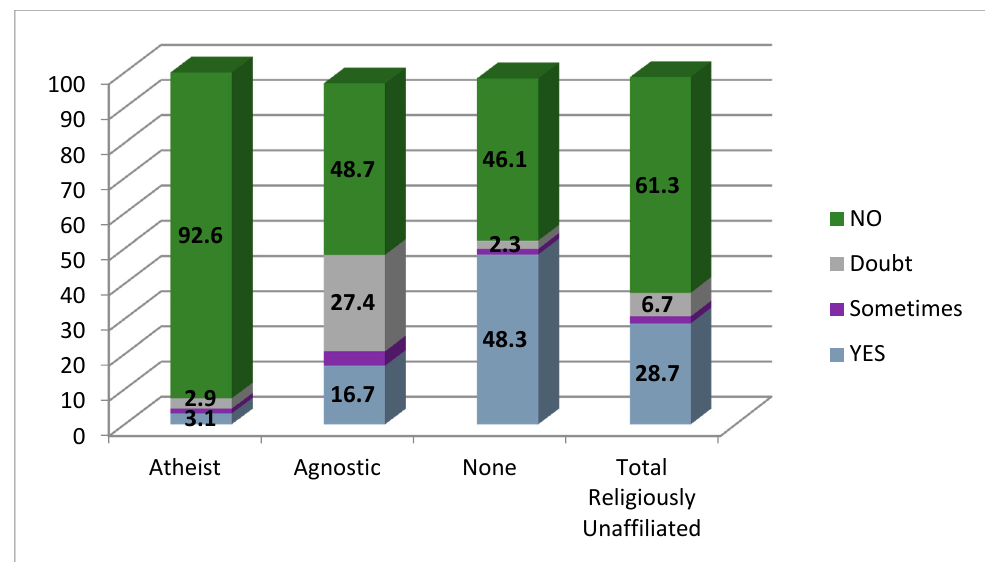
Figure 3. Belief in God of the religiously unaffiliated (in %). Based on 382 cases. Source: Author’s elaboration based on the Second National Survey on Religious Beliefs and Attitudes. Society, Culture and Religion Program, CEIL-CONICET, 2019. The percentages do not add up to 100, since “don’t know/no opinion” were excluded.